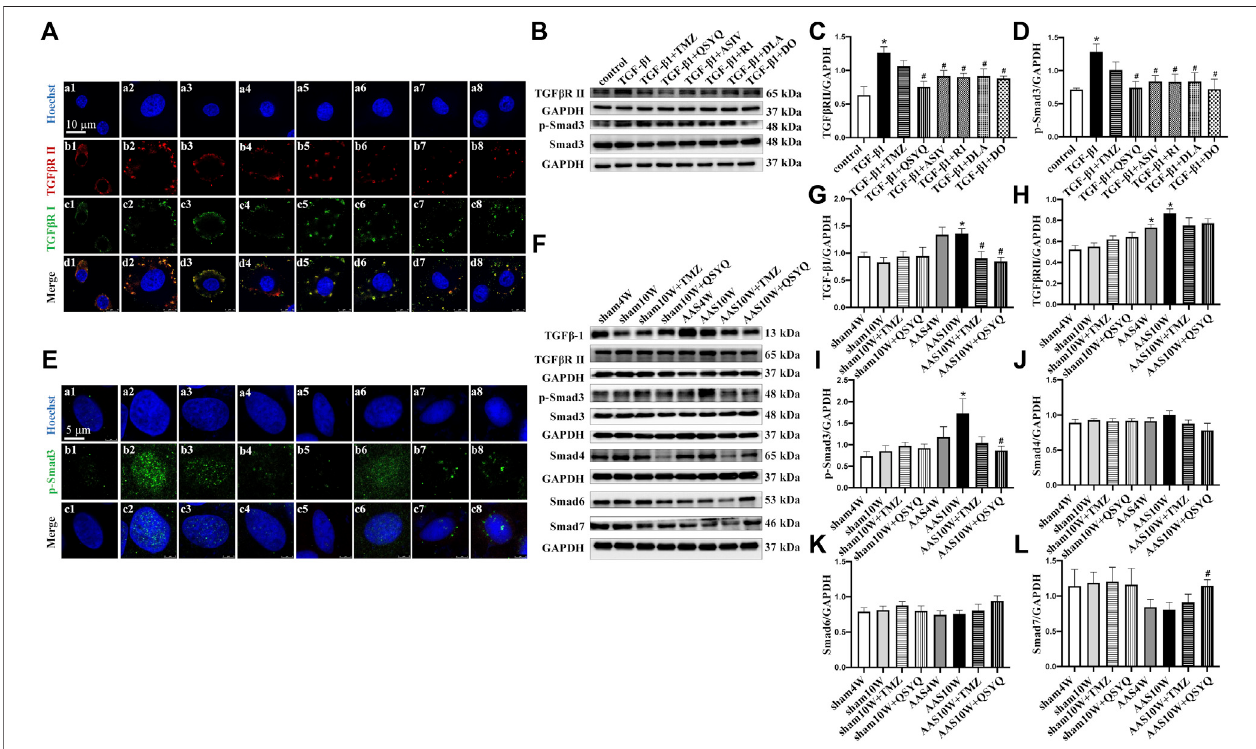
FIGURE5| QSYQinhibitedAAS-inducedincreasesofTGF- β 1anditsreceptorTGF β RIIaswellasactivationofSmads. (A) Immuno fl uorescenceimagesofTGF β R II, TGF β R I, and nucleus in RDF cells in the control (a1, b1, c1, and d1), TGF- β 1 (a2, b2, c2, and d2), TGF- β 1+TMZ (a3, b3, c3, and d3), TGF- β 1+QSYQ (a4, b4, c4, and d4),TGF- β 1+ASIV(a5,b5,c5,andd5),TGF- β 1+R1(a6,b6,c6,andd6),TGF- β 1+DLA(a7,b7,c7,andd7),andTGF- β 1+DO(a8,b8,c8,andd8)groups. (B) Expression ofTGF β RII,p-Smad3,andSmad3inRDFcellsexaminedbyWesternblot. (C,D) Quanti fi cationoftheWesternblotresultsforTGF β RIIandp-Smad3/Smad3.Data are presented as the mean ± SEM, n = 4. (E) Immuno fl uorescence images of p-Smad3 and nuclei in RDF cells. Scale bar = 25 μ m. (F) Expression of TGF- β 1, TGF β R II, p-Smad3, Smad4, Smad6, and Smad7 in rat myocardium examined by Western blot. (G – L) Quanti fi cation of the Western blot results for TGF- β 1, TGF β R II, p-Smad3/ Smad3, Smad4, Smad6, and Smad7 in Panel 5E. Data are presented as the mean ± SEM, n = 4. * p < 0.05 vs. sham or control; # p < 0.05 vs. AAS or TGF- β 1.